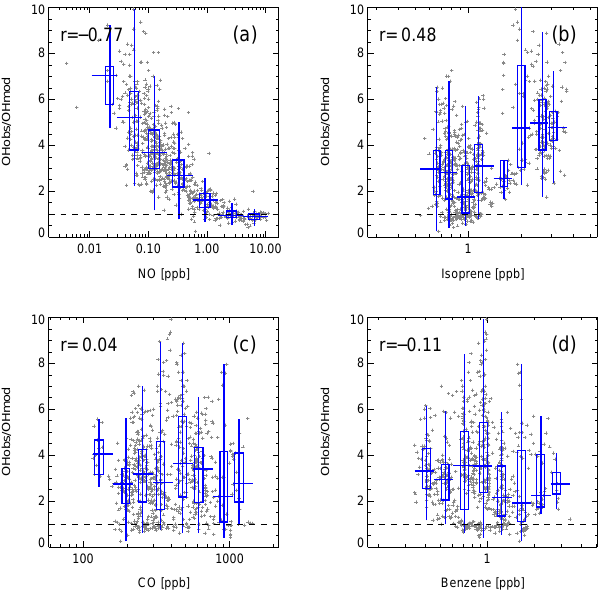
Fig. 9. Measured-to-modelled OH ratios, OH obs / OH mod , plotted versus the mixing ratios of (a) NO, (b) isoprene, (c) CO, and (d) benzene. The data have been filtered for j (O 1 D) ≥ 1 × 10 − 5 s − 1 and are presented as individual data points (crosses) and in box-and-whisker style (the bottom and top of the boxes mark the lower and upper quartiles, respectively), horizontal lines denote median values, and the lower and upper whiskers the minimum and maximum values, respectively. Correlation coefficients, r , between OH obs / OH mod and the logarithmic values of NO, isoprene, CO and benzene are shown in corresponding panels as well.